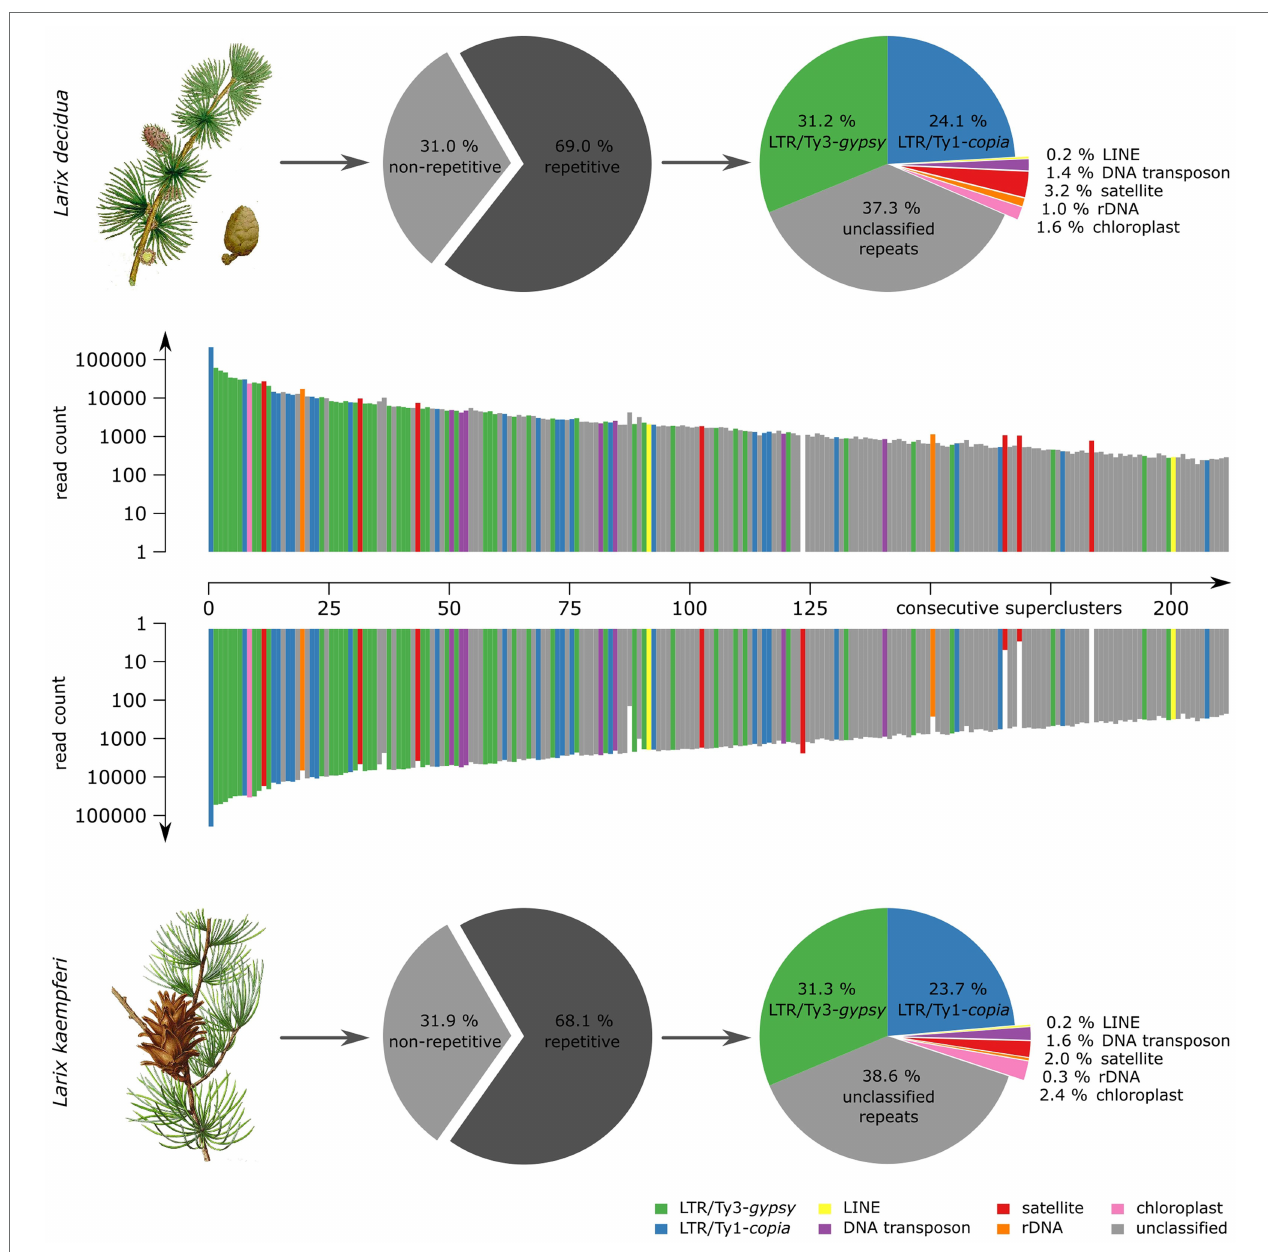
FIGURE 1 | Comparison of repetitive genome fractions reveals high genomic similarity over all repeat types between Larix decidua and Larix kaempferi . At the center of each figure, a two-sided bar plot shows 214 repeat superclusters with respective read counts in L. decidua (top) and L. kaempferi (bottom). The read count is presented on a logarithmic scale. The composition of each Larix repeat fraction is summarized by pie charts. The plant illustrations are reproduced from Woodville, W., Hooker, W.J., and Spratt, G., Medical Botany, 3th edition, vol. 1: (1832; L. decidua ) and M. E.-A. Carriere (ed.) Revue Horticole, serié 4, vol. 40: (1868), Paris ( L. kaempferi